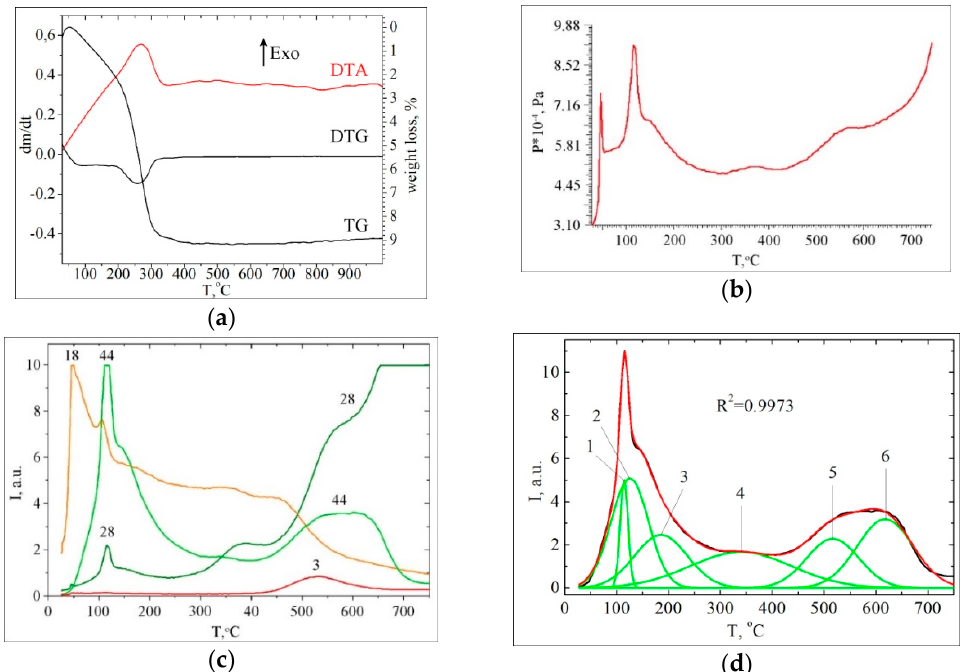
Table 2. Pyrolysis yields for thermogravimetric analysis (TGA) pyrolysis of CA/CeO 2 (0.6 mmol/g).